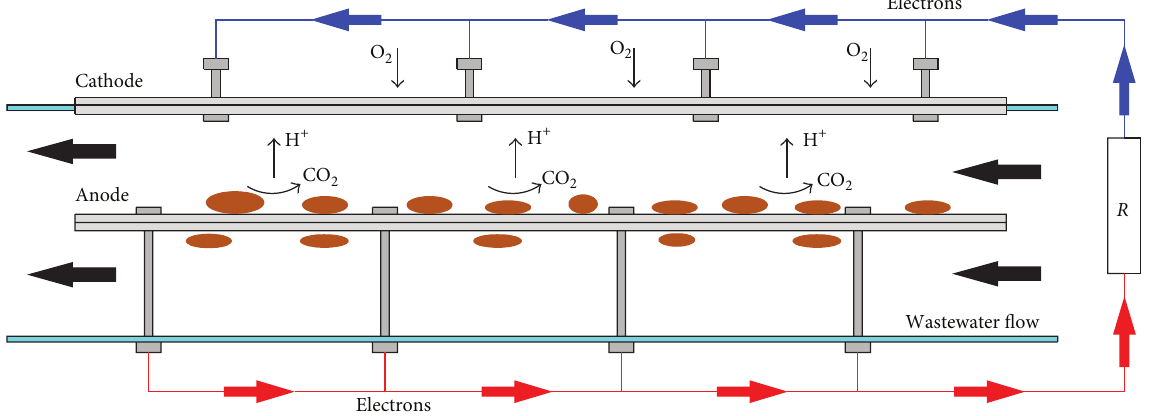
Figure 2: Working principle of MFC